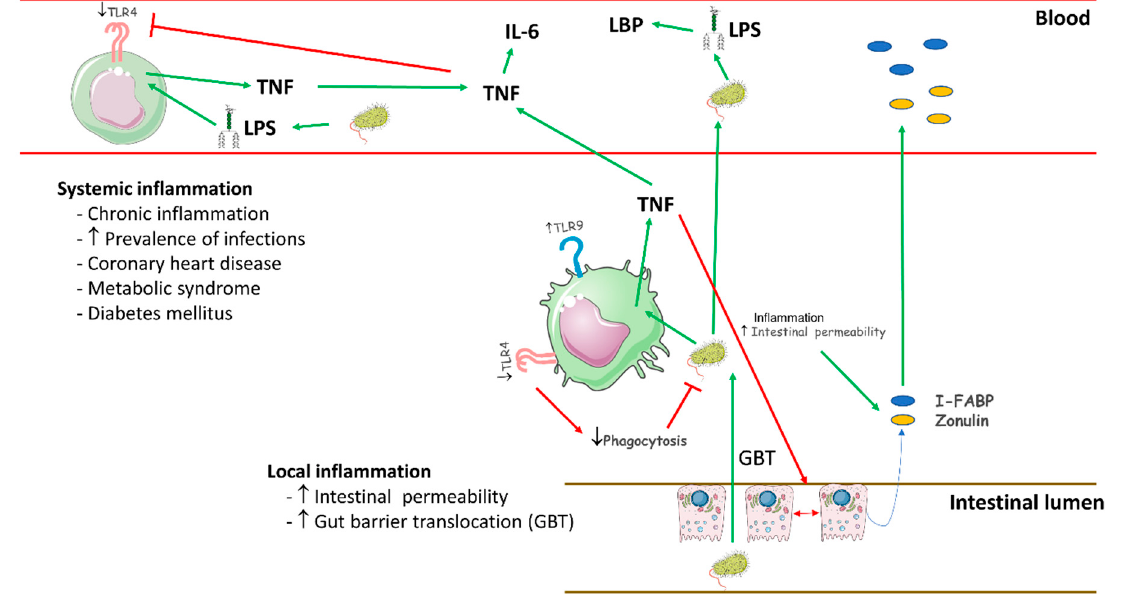
Figure 8. Schematic representation of pathology in chronic SCI patients.